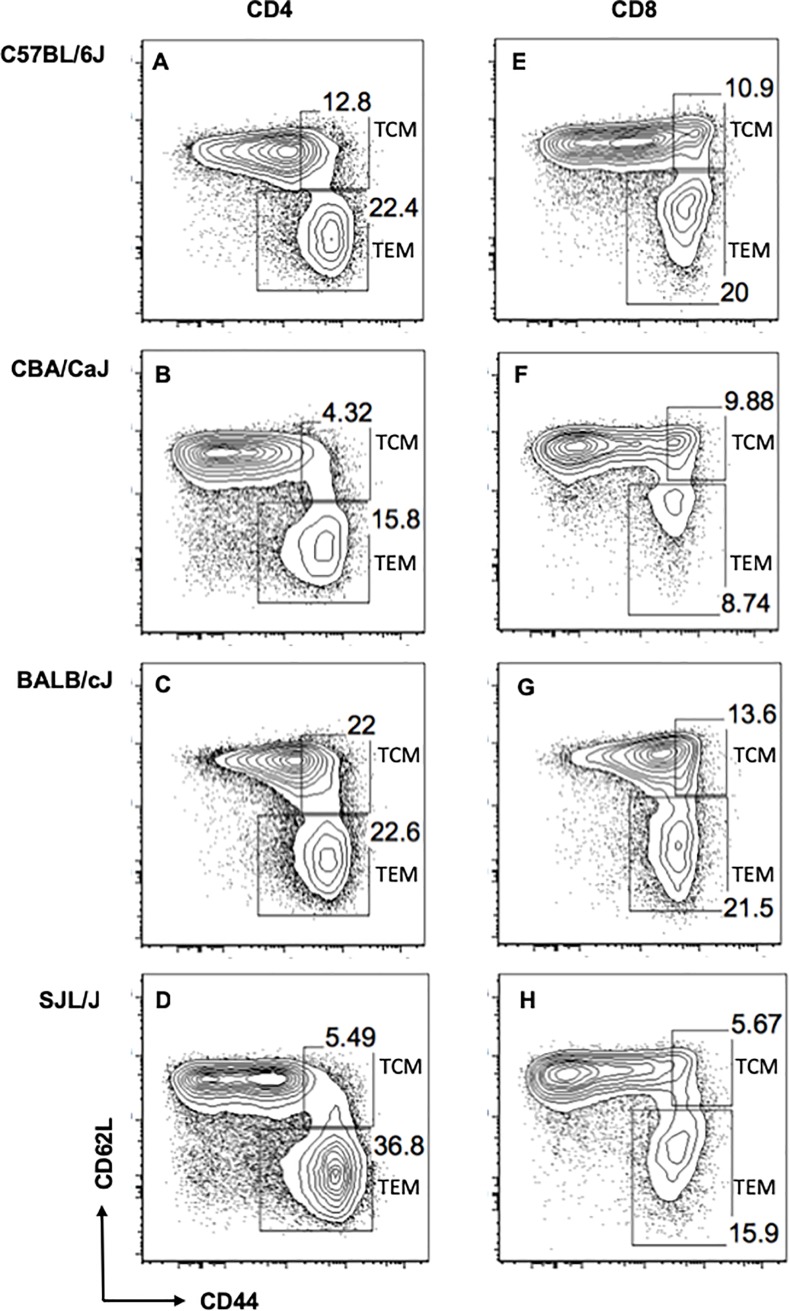
Gating strategy for memory subsets in mouse splenic CD4 T cells (A to D) and CD8 T cells (E to H). Each plot shows representative gates from a single mouse strain as indicated. CD4 memory subsets are gated on conventional CD4+ CD25- gate. CD8 memory subsets are gated on CD8+ gate. Central memory (TCM) subset is defined as CD44hi CD62Lhi and Effector memory (TEM) subset is defined as CD44hi CD62Llo. Boxes indicate TCM and TEM gates as depicted.